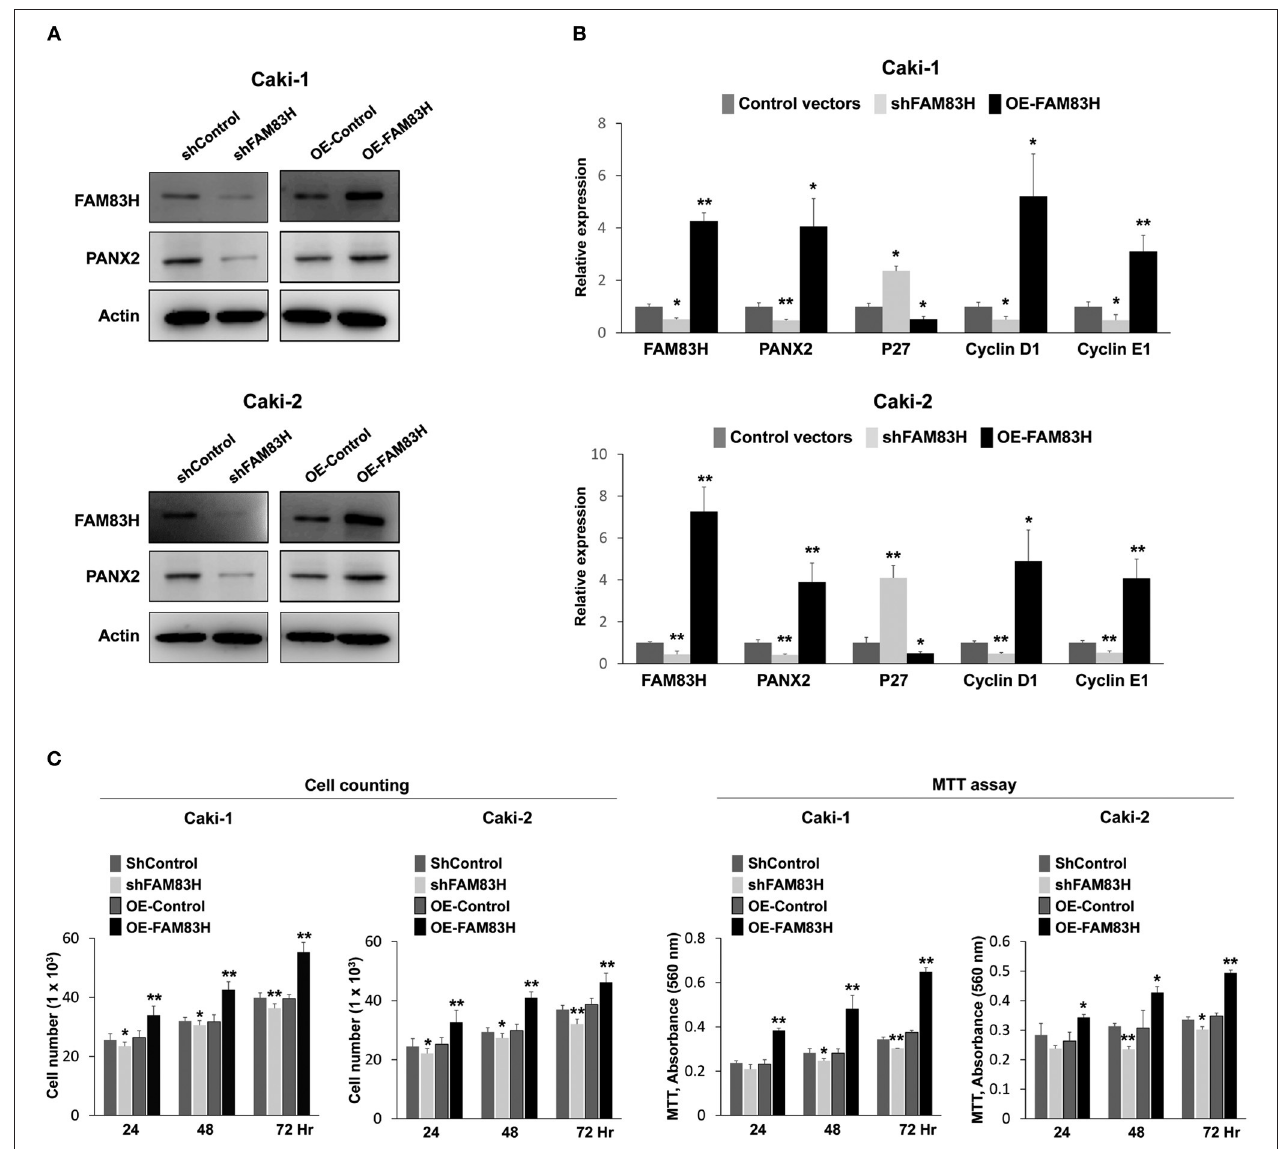
FIGURE 4 | The effect of SIRT6 on the proliferation of CCRCC cells. (A) Western blotting for FAM83H, PANX2, and actin after knock-down of FAM83H or overexpression of FAM83H in Caki-1 and Caki-2 CCRCC cells. (B) Quantitative reverse-transcription polymerase chain reaction for FAM83H, PANX2, P27, cyclin D1, and cyclin E1 after knock-down of FAM83H or overexpression of FAM83H in Caki-1 and Caki-2 CCRCC cells. (C) Counting the number of cells and an MTT assay were performed to evaluate the effects of knock-down or overexpression of FAM893H on proliferation of Caki-1 and Caki-2 CCRCC cells. The P values were calculated by student’s t -test. OE; overexpression, *vs. control, P < 0.05, **vs. control, P <